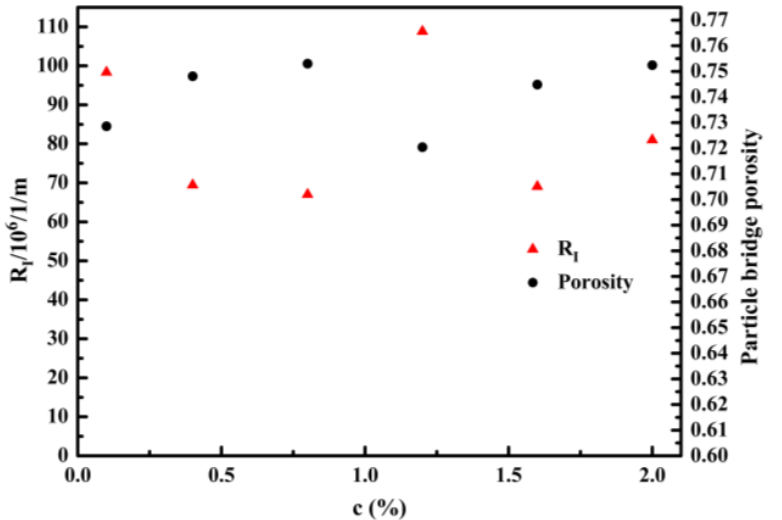
Figure 9. Effect of particle concentration on interference resistance and particle bridge porosity.